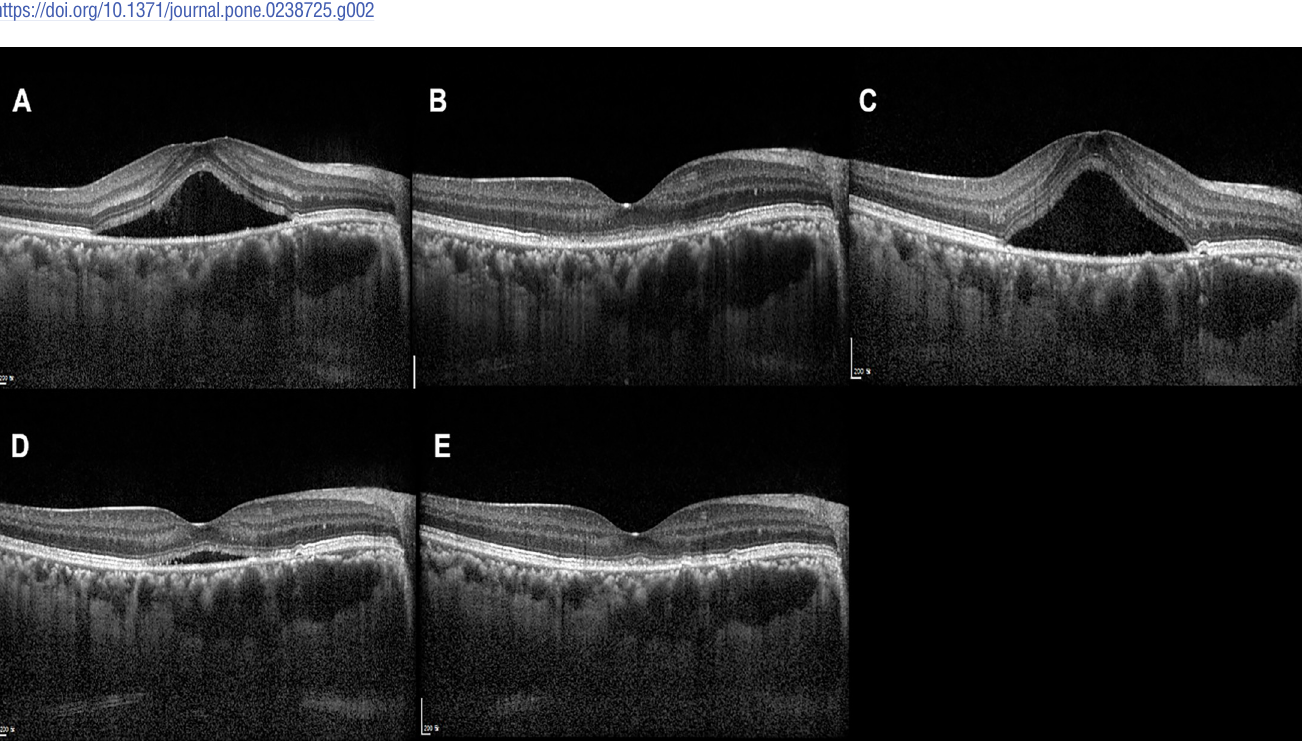
Fig 3. Image from a 34-year-old female patient with acute central serous chorioretinopathy (CSC) in the right eye. She complained of blurred vision in the right eye for 2 months, and the best-corrected visual acuity (BCVA) was 0.3 logarithm of the minimum angle of resolution (logMAR). (A) Subretinal fluid (SRF) with hyper- reflective dots was noted. (B) A single intravitreal bevacizumab injection (IVBI) led to resolution of SRF, and the BCVA improved to 0 logMAR. (C) After 24 months, CSC recurred, and the BCVA in the right eye was 0.5 logMAR. (D) IVBI was performed, but SRF did not completely resolve, and (E) additional IVBI was needed to resolve the SRF, and the BCVA improved to 0.2